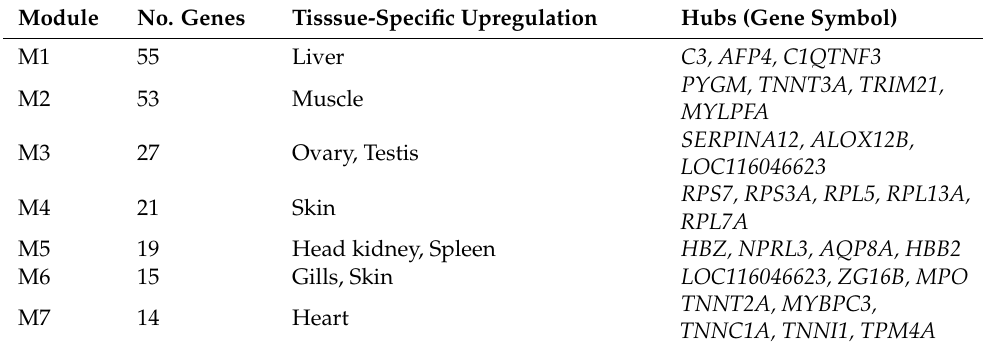
Table 4. Tissue-specific (differential) co-expression modules with their hub